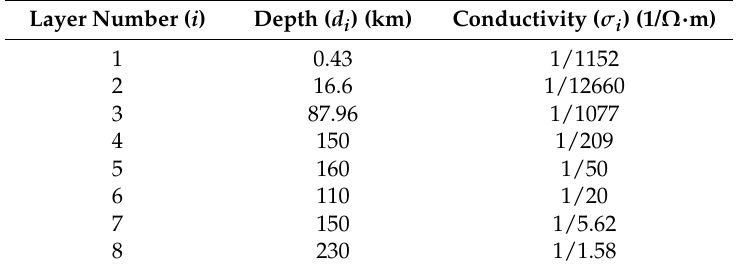
Table 1. Developed 1-D layered earth conductivity model in Korea for the geoelectric field calculation.